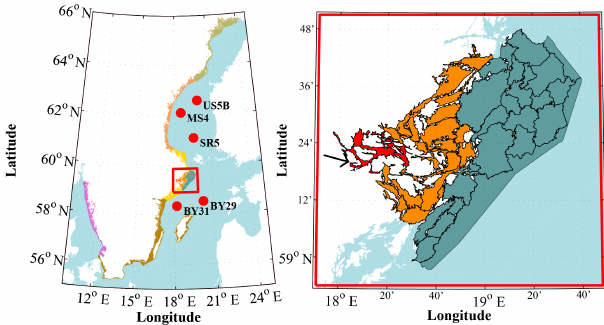
Figure 2. The Swedish Coastal zone Model can be used in different areas along the Swedish coast, stretching from the Norwegian bor- der in the west to the Finnish border in the north (different colours, left). In the present study the SCM covers the northern Baltic proper (marked with a red square) and has been used to estimate the coastal filter efficiency of nutrients in the Stockholm inner (red), intermedi- ate (orange) and outer (blue) archipelagos (right). The outlet of the river Norrström is marked by a black arrow and the different basins are shown by the black